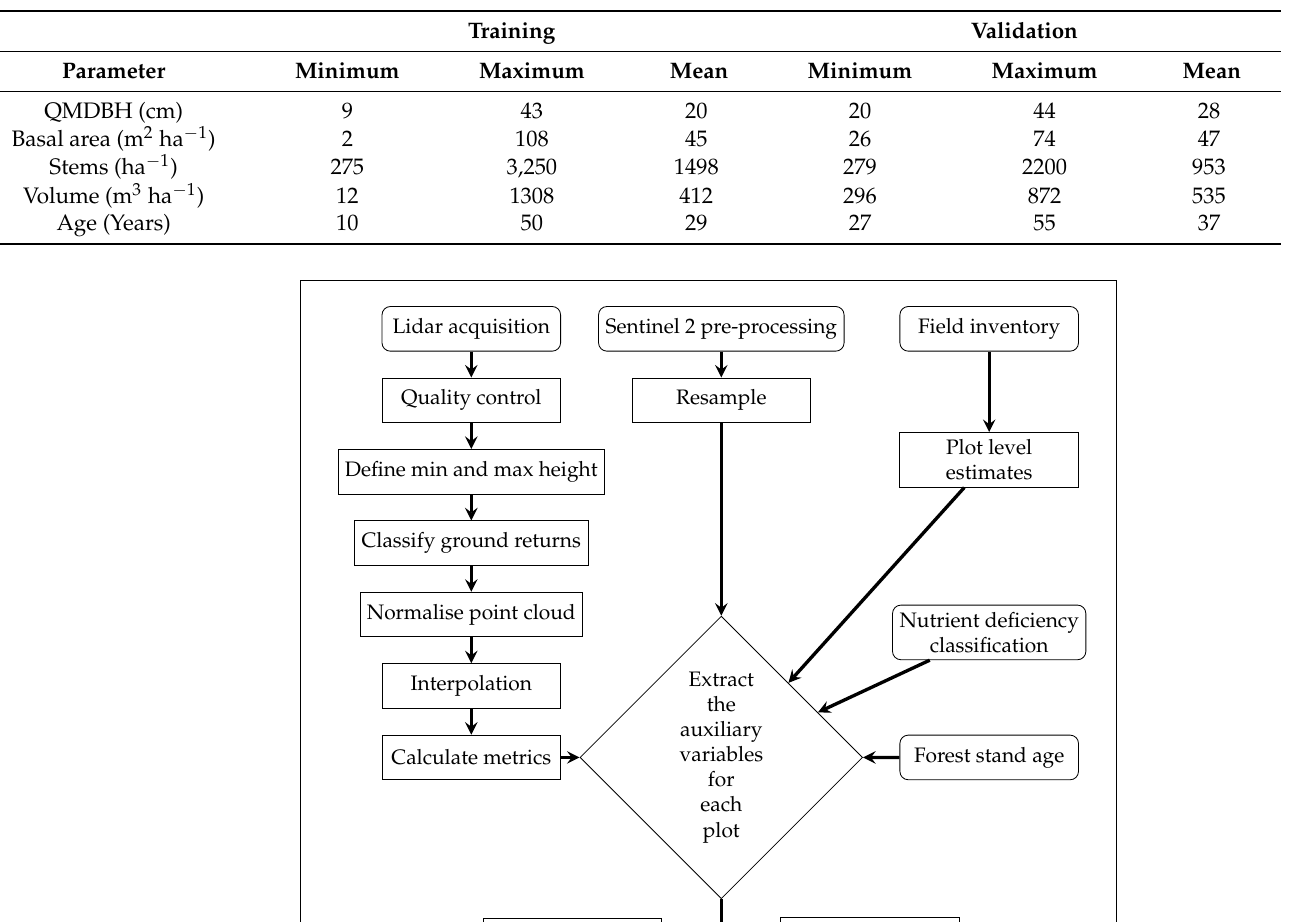
Table 2. Field inventory measurements.